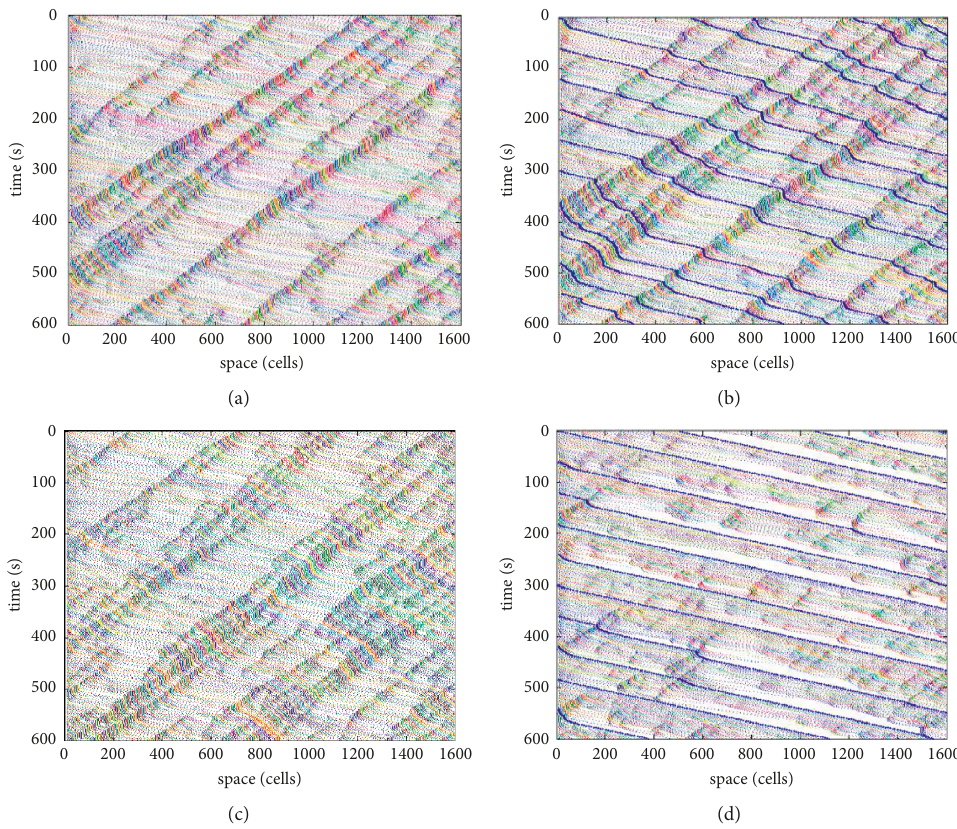
Figure 3: Time-space distributions. (a) Time-space distribution of the left lane in Group A. (b) Time-space distribution of the right lane in Group A. (c) Time-space distribution of the left lane in Group B. (d) Time-space distribution of the right lane in Group